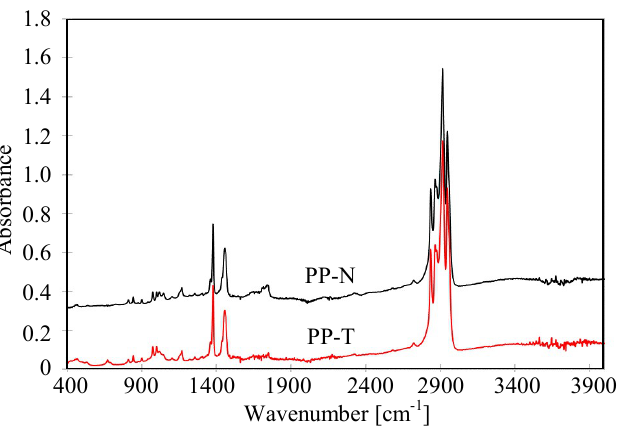
Figure 12. Results of FTIR analysis of tested PP-N and PP-T membranes.